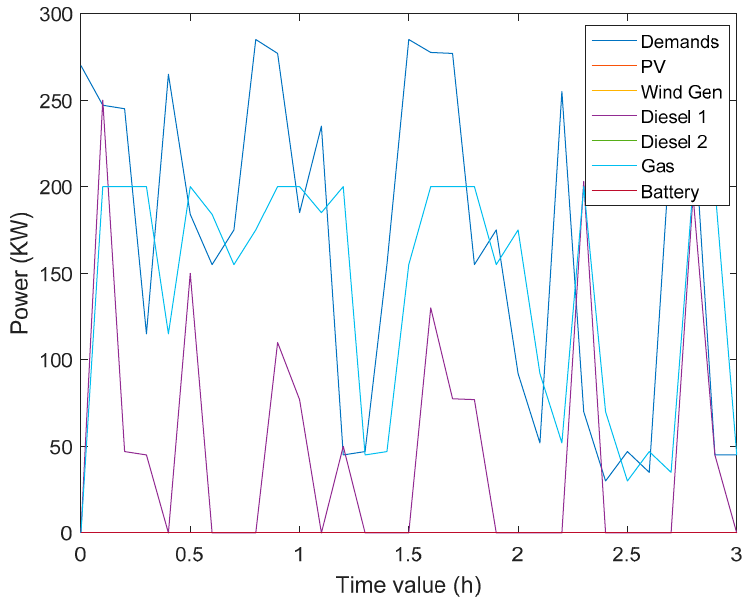
Figure 12. Ship power generation and consumption during Scenario 3. Load Demands (blue), DG1 (purple), LNG (light blue), DG2 (deactivated), PVs (deactivated), WECs (deactivated).